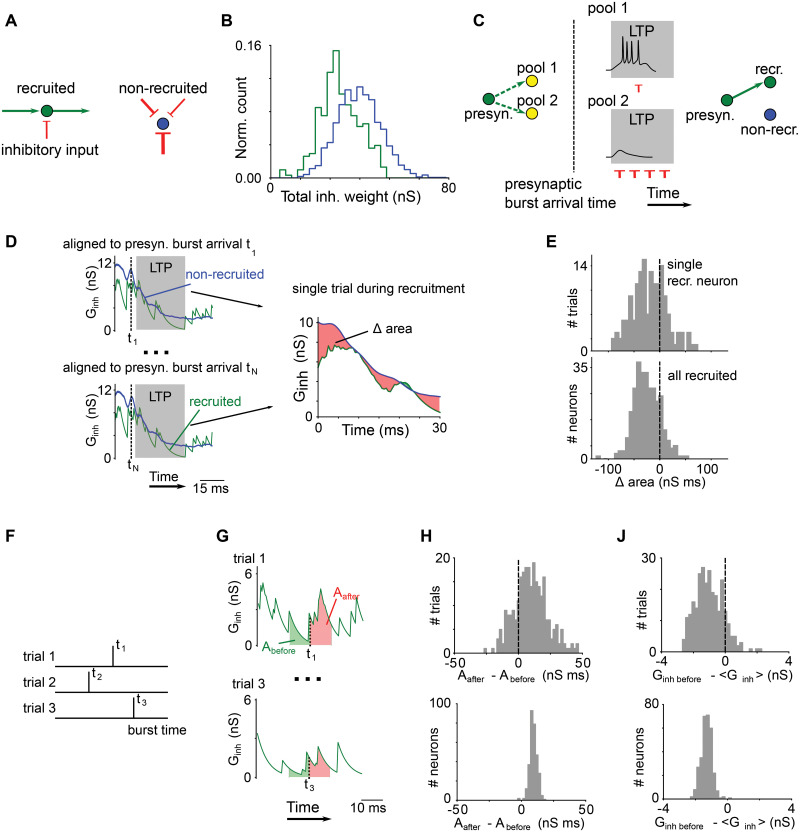
The role of inhibition in the network growth.A-B: Comparison of inhibitory weights onto the recruited and the non-recruited neurons. A: A recruited neuron (green circles) receives strong excitation (green arrow) and weak inhibition (red arrow). A non-recruited neuron (blue circles) receives larger inhibitory inputs. B: Distribution of the total inhibition, computed as the sum of all inhibitory input conductance to the neuron, shows stronger inhibition onto the non-recruited HVCRA neurons (blue) compared to the recruited neurons (green), p < 10−39, Wilcoxon rank-sum test. C-E: Comparison of the temporal profile of inhibitory conductance aligned to the presynaptic neuron bursts during the network growth. C: Illustration of how inhibition determines which HVCRA neurons get recruited into the network. Left: the presynaptic HVCRA neuron (green circle) may form connections to two pool HVCRA neurons (yellow circles) during the network growth. Middle: When aligned to the presynaptic burst arrival time, pool neuron 1 receives weak inhibition (red arrows) in the LTP window, defined as the time interval in which bursting of the pool neuron leads to a significant strengthening of the connection from the presynaptic neuron. Due to weak inhibition, pool neuron 1 can spike. Pool neuron 2 receives strong inhibition in the LTP window and its spiking activity is suppressed. Right: Eventually pool neuron 1 gets recruited into the network, while pool neuron 2 remains not recruited. D: Left: For each recruited neuron during the network growth, the temporal profile of inhibitory conductance is aligned to the burst arrival times of all presynaptic parent neurons (green). Note that these arrival times are synchronous but have small jitters across different presynaptic neurons. At each trial, the inhibitory conductance in the LTP window is averaged across all parent neurons during the network growth. For comparison, we use an averaged inhibitory conductance of all non-recruited HVCRA neurons extracted in the same time intervals. Right: The inhibitory conductance in the LTP window averaged for all presynaptic burst alignments is compared between the recruited (green) and the non-recruited (blue) neurons using the area Δ under the conductance curve. E: Top: Δ for a single recruited neuron during the network growth until the neuron is recruited. Bottom: Δ for all recruited neurons. For each recruited neuron, we use the median Δ across all trials until the neuron recruitment. Distribution has a negative shift, meaning that the recruited neurons receive smaller inhibitory conductance in the LTP window during the recruitment, p < 10−34, Wilcoxon signed-rank test. F-H: Comparison of the temporal profile of inhibitory conductance aligned to the postsynaptic neurons during the network growth. F: Burst times of a neuron being recruited at different trials. G: The inhibitory conductance profile is aligned to the burst onset times of the recruited neurons. Difference in inhibitory conductance in time windows 10 ms after and 10 ms before the burst is calculated using the area under the conductance curve, Abefore and Aafter. (h) Top: Abefore − Aafter for a single recruited neuron during the network growth until the neuron is recruited. Bottom: Abefore − Aafter for all recruited neurons. For each recruited neuron, we used the median of the difference across all trials until the neuron recruitment. The distribution has a positive shift, meaning that the recruited neurons receive stronger inhibition after the burst, p < 10−51, Wilcoxon signed-rank test. J: Top: The difference in inhibitory conductance 10 ms before the burst and the mean inhibitory conductance in the trial for a single recruited neuron during the network growth until the neuron is recruited. Bottom: The distribution of the difference for all recruited neurons. For each recruited neuron, we used the median of the differences in all trials until the neuron recruitment. The distribution has a negative shift, meaning that the recruited neurons receive smaller inhibition before the burst compared to the average inhibition during the entire trial, p < 10−51, Wilcoxon signed-rank test.